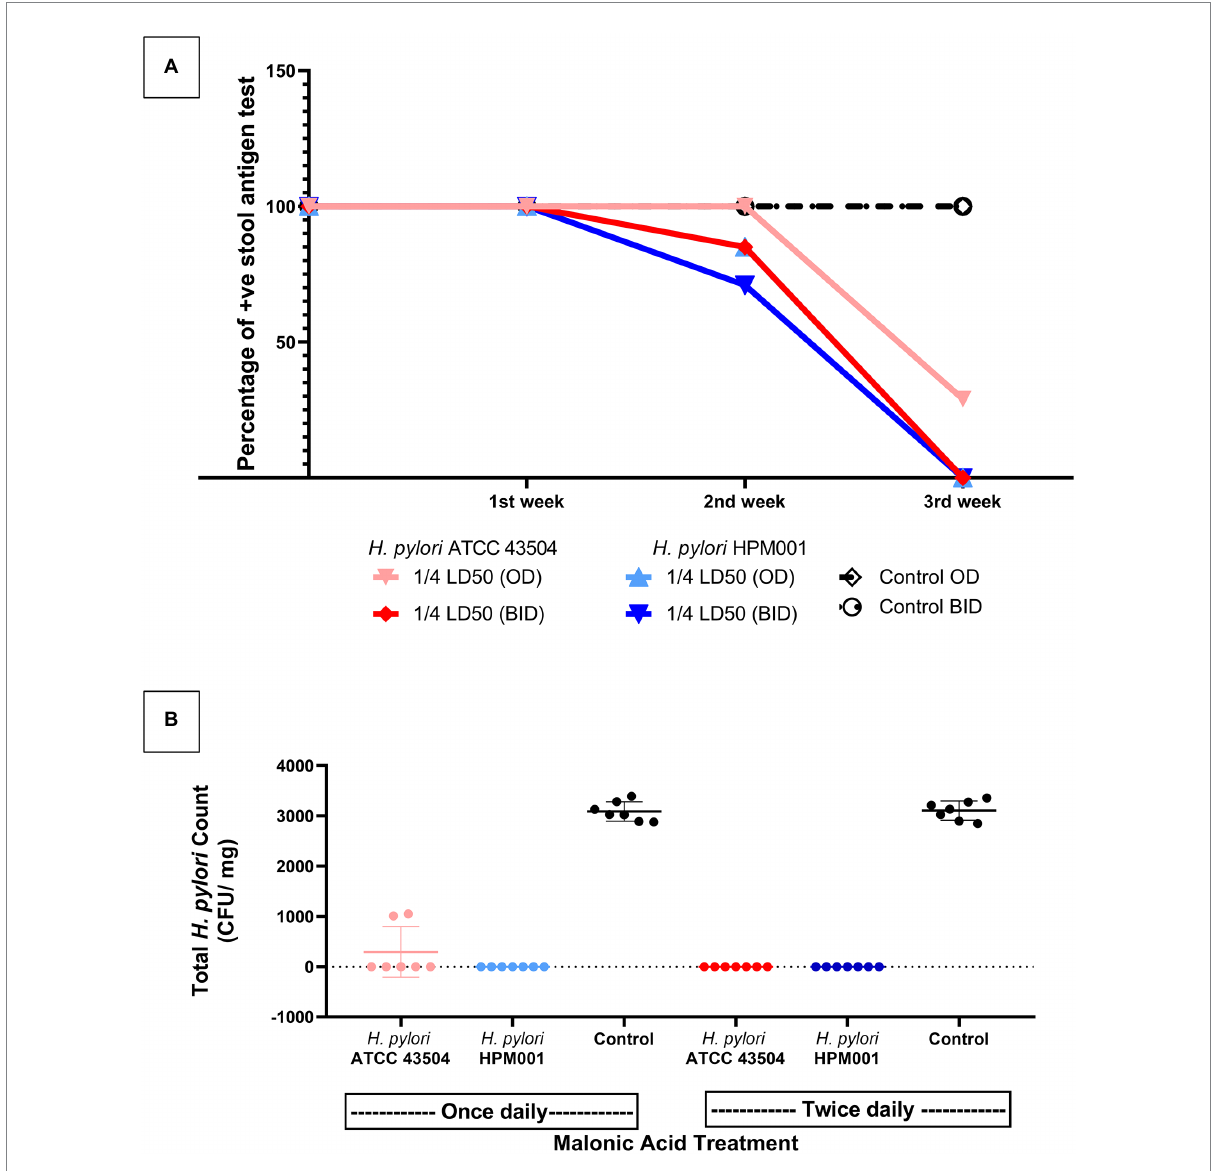
FIGURE 6 Inhibition of aspartate- α -decarboxylase successfully treated Helicobacter pylori infected rats. (A) Weekly follow up of the number of rats that cleared infection with either H . pylori ATCC 43504 or the clinical H . pylori HPM001 strains as indicated by H . pylori Stool Antigen (HpSA) test during the 3 weeks treatment period. (B) The total H . pylori count in the stomachs of malonic acid treated and untreated (control) groups of rats at the end of the 3 weeks treatment period. OD, once daily; BID, twice daily; LD 50 , lethal dose 50; Control, rat groups that received sterile water instead of malonic